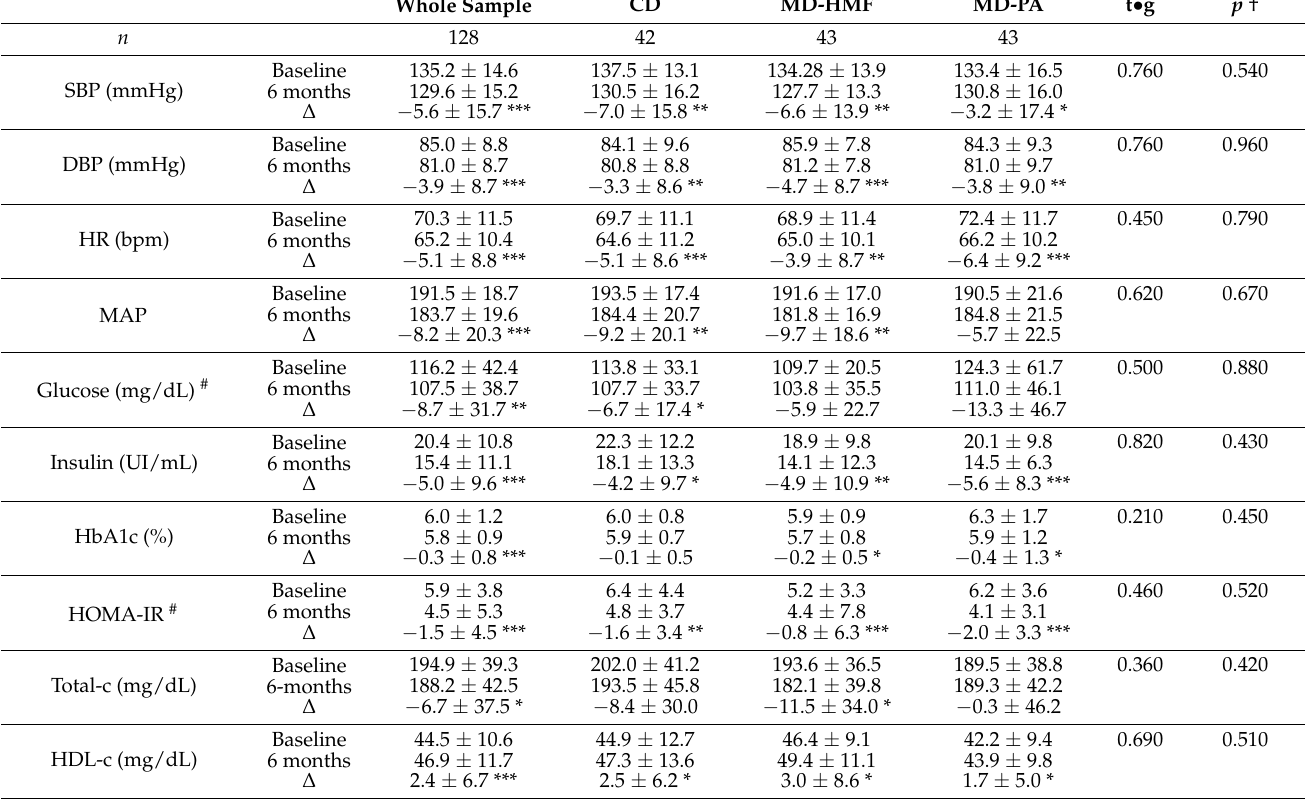
Table 3. Changes in clinical and biochemical parameters within and between intervention groups at 6 months versus baseline. Whole